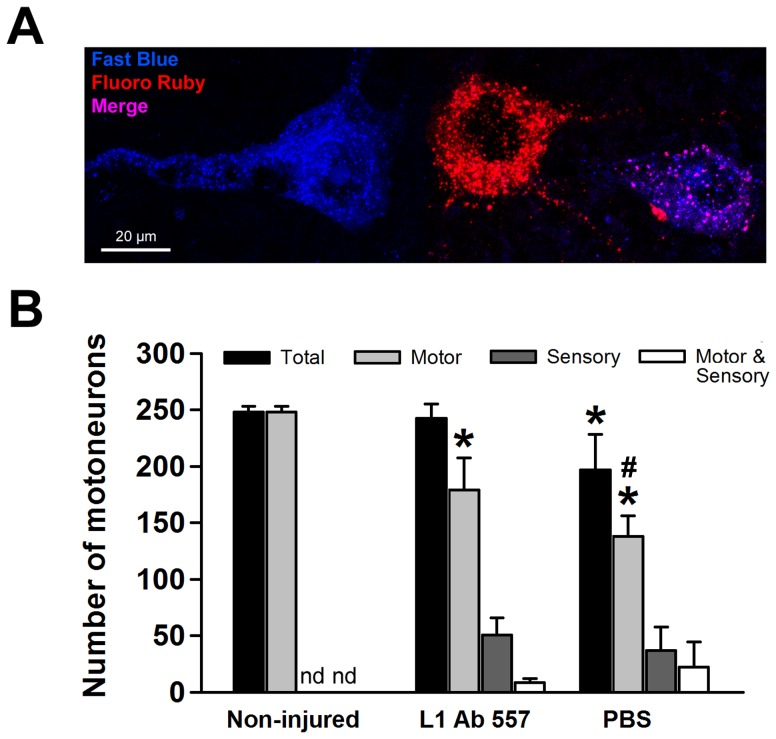
Analysis of axonal regrowth and/or survival of motoneurons.(A) Representative image of motoneurons labeled with Fast Blue (blue, correctly regrown into the motor branch), Fluoro Ruby (red, incorrectly regrown into the sensory branch), and merge (violet, regrown into both branches, motor and sensory). (B) Mean numbers of regenerated motoneurons (+ SEM) labeled through the motor branch only (light gray bars, “Motor”), the sensory branch only (dark gray bars, “Sensory”) and the sum of neurons labeled both through motor and sensory branches (black bars, “Total”) 12 weeks after injury in mice treated with L1 Ab 557 or PBS. In non-injured mice, retrograde tracing was performed without previous injury. In this group, no incorrectly projecting neurons (white bars, “Motor & Sensory”) are detected (nd). Ten mice per group were analyzed. Asterisks indicate differences in number of motoneurons between non-injured and injured groups. Cross-hatches show differences in number of motoneurons between groups treated with L1 Ab 557 or PBS (*p<0.05, #p<0.05, one-way ANOVA with Tukey's post hoc test).